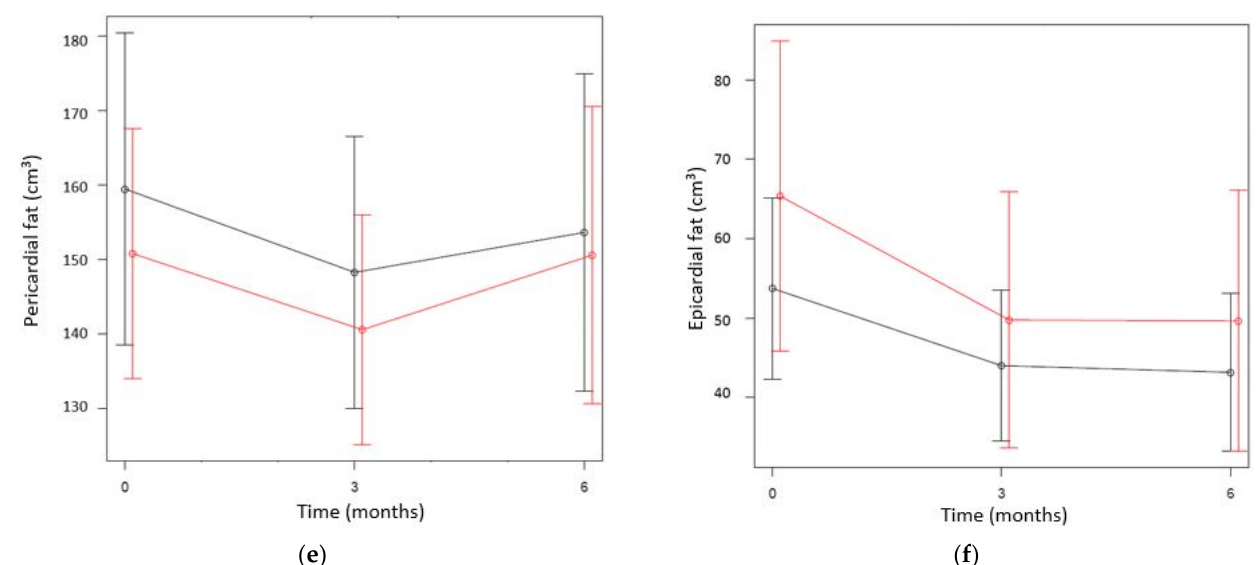
( e ) ( f ) Figure 4. Mean values of ectopic fat deposition and SAT at each time point. The error bars represent the 95% confidence intervals around the mean. Black line: UC group (diet); red line: I group (diet + exercise). ( a ) IHL over time, ( b ) IMCL over time, ( c ) VAT over time, ( d ) SAT over time, ( e ) PCF over time and ( f ) ECF over time.